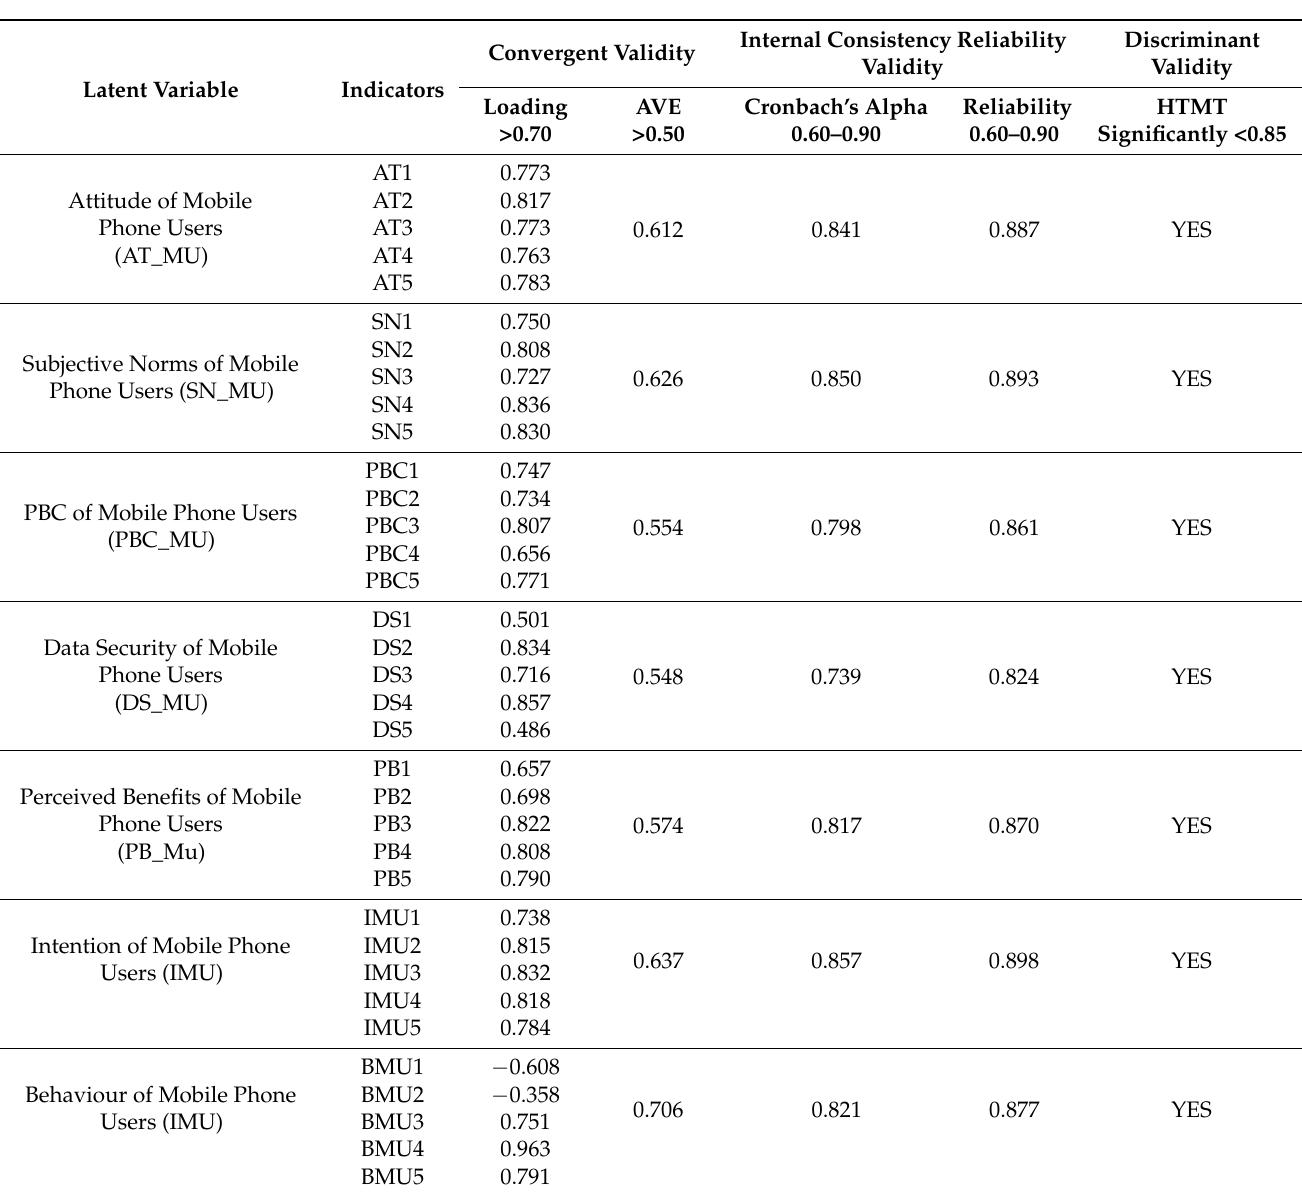
Table 3. Summary for the measurement